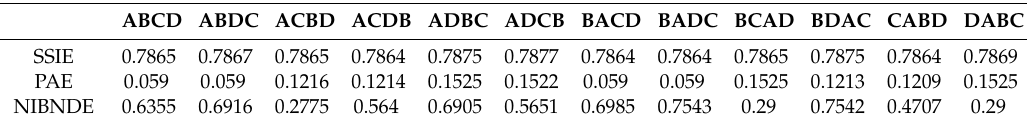
Figure 5. Circuit diagrams of the single switched-inductor equalizer (SSIE) ( a ), the parallel architecture equalizer (PAE) ( b ) and the NIBNDE with four cells ( c ). Table 2. The balancing time in different distribution sequences for SSIE, PAE and NIBNDE (time unit: seconds).